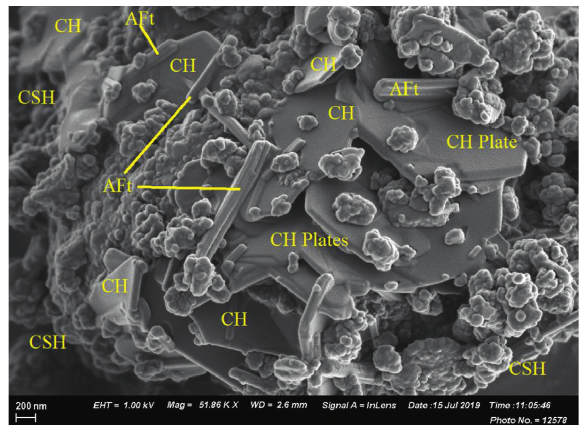
Figure 1: SEM image (i) OPC (H